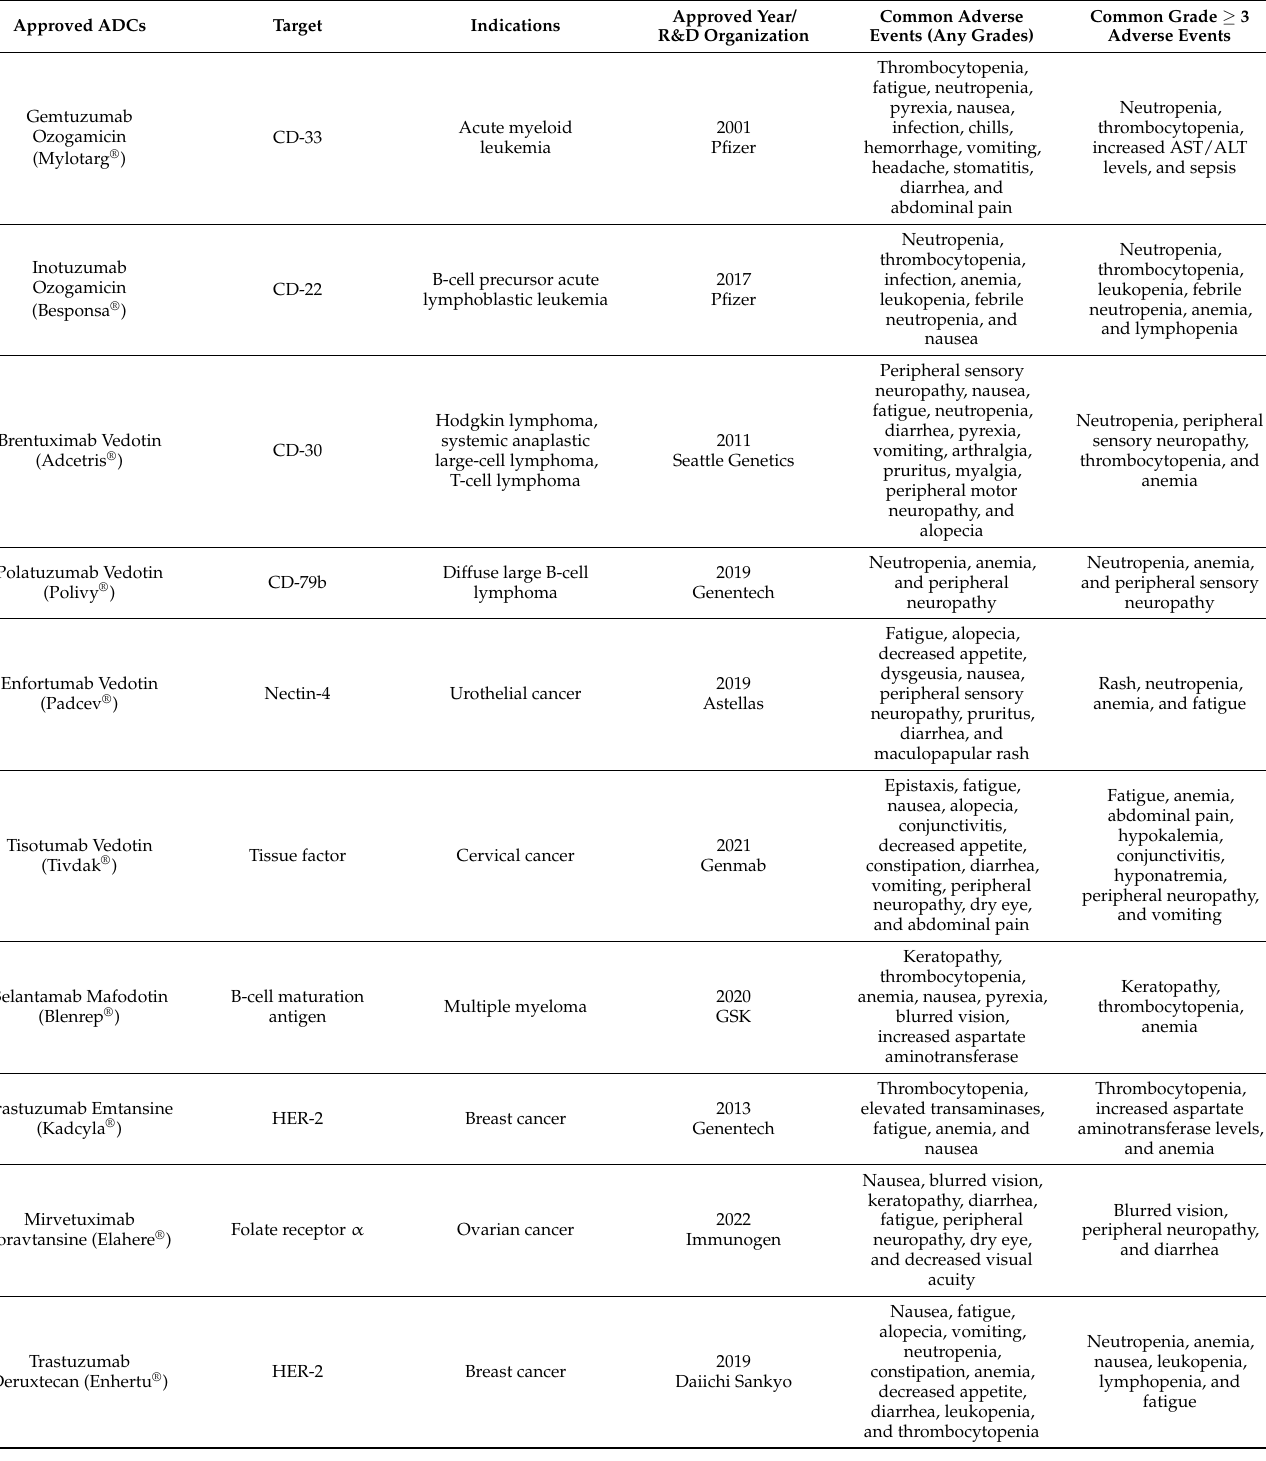
Table 1. Summary of the approved ADCs and their common adverse